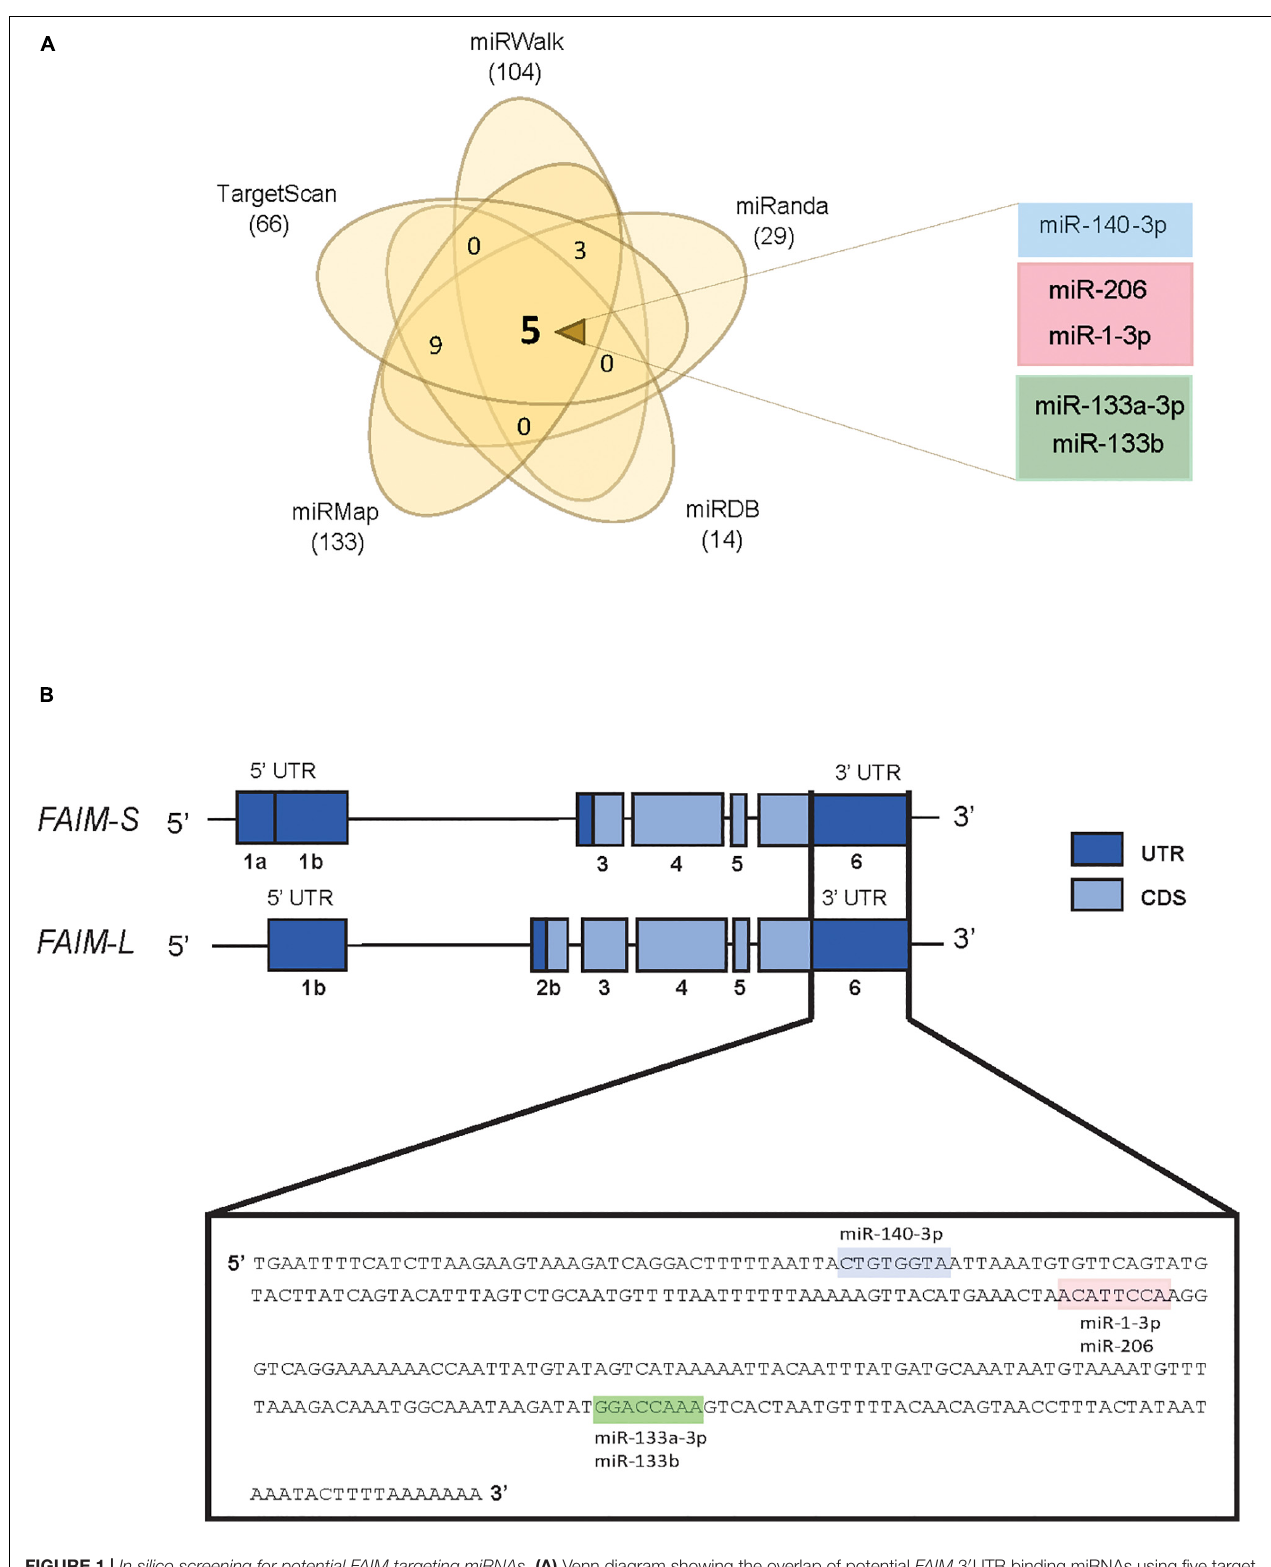
FIGURE 1 | In silico screening for potential FAIM targeting miRNAs. (A) Venn diagram showing the overlap of potential FAIM 3 (cid:48) UTR binding miRNAs using five target prediction tools. (B) Schematic representation of the two main FAIM isoforms. Labels shows the miR-140-3p (blue), miR-206/miR-1-3p (pink) and miR-133a-3p/miR133b (green) binding sites in the 3 (cid:48) UTR of FAIM. UTR: untranslated region; CDS: coding sequence.